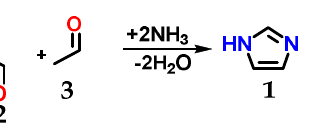
Figure 2. Scheme of the synthesis of imidazole 1 using glyoxal 2 and formaldehyde 3 in ammonia.